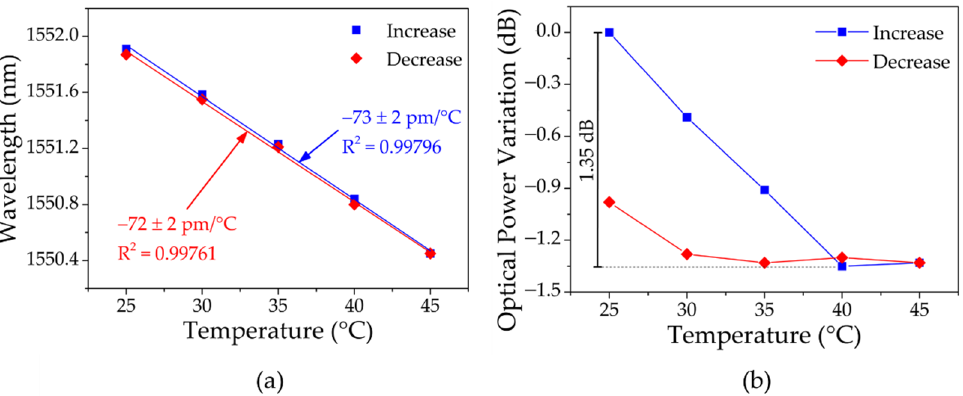
Figure 16. Resulting signal response from the PMMA mPOF gratings to the increasing/decreasing temperature: ( a ) wavelength; ( b ) optical power variation.